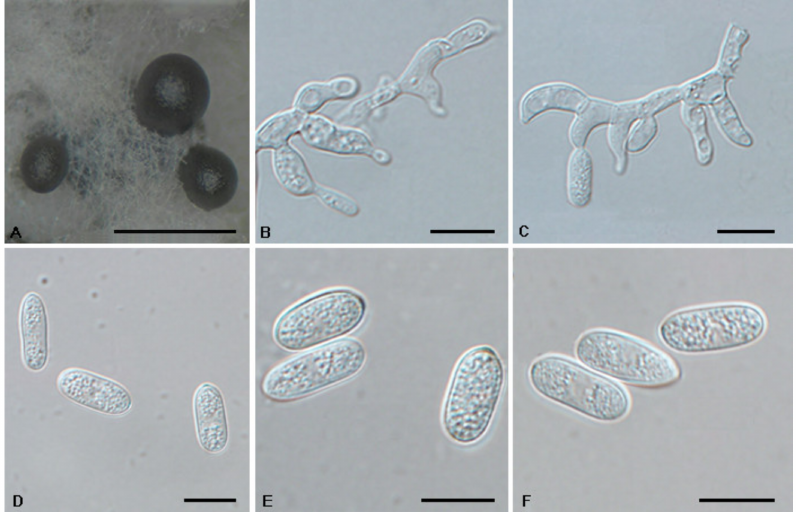
Figure 9. The morphology of Tubakia dryinoides (CFCC 54949). ( A ) Conidioma formed on PDA; ( B – C ) Conidiogenous cells giving rise to conidia; ( D – F ) Conidia. Scale bars: ( A ) = 500 µ m; ( B – F ) = 10 µ